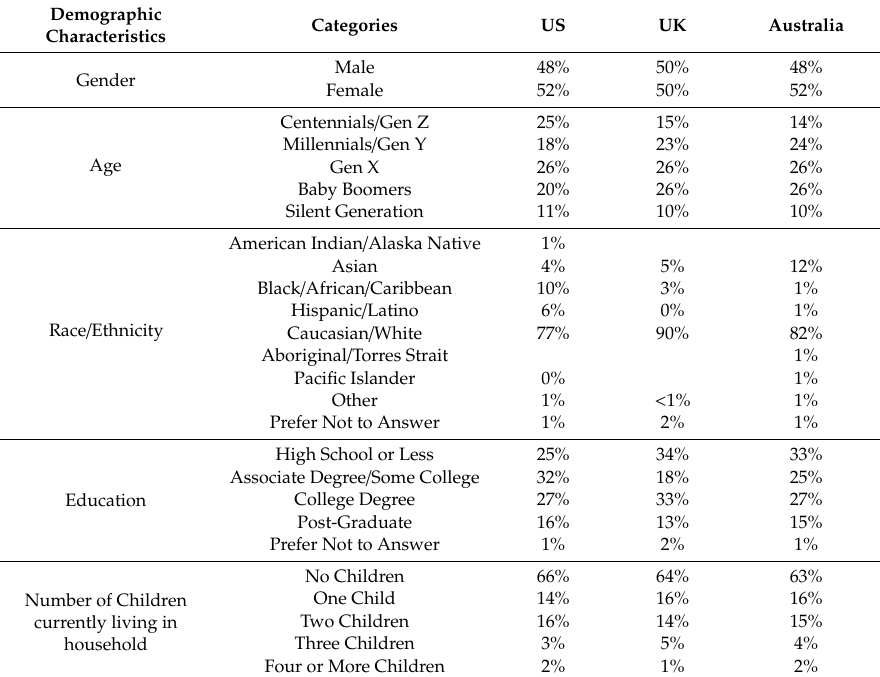
Table 1. Demographic percentages *.